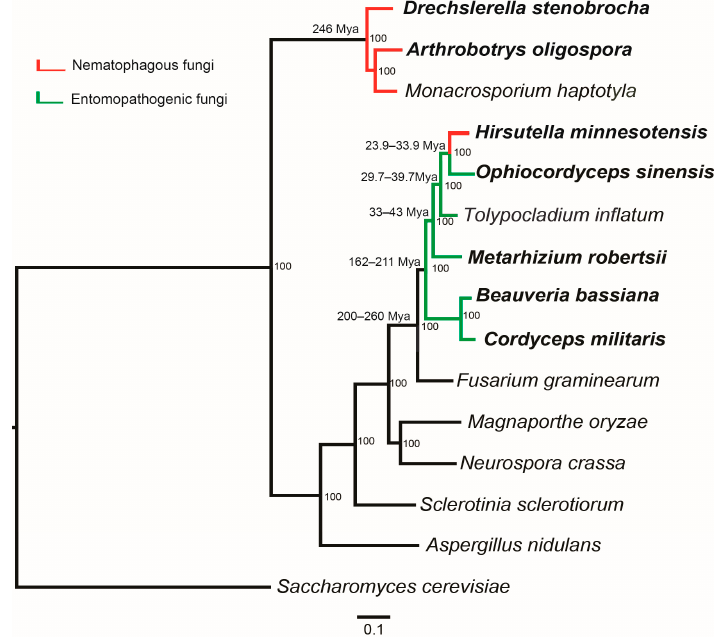
Figure 2. Genome-based phylogenetic tree of nematophagous fungi and other fungi. Bootstrap values and divergence time are indicated beside the nodes; color of branches corresponds to the lifestyle character states as follows: red, nematophagous fungi; green, entomopathogenic fungi; black, other fungi.